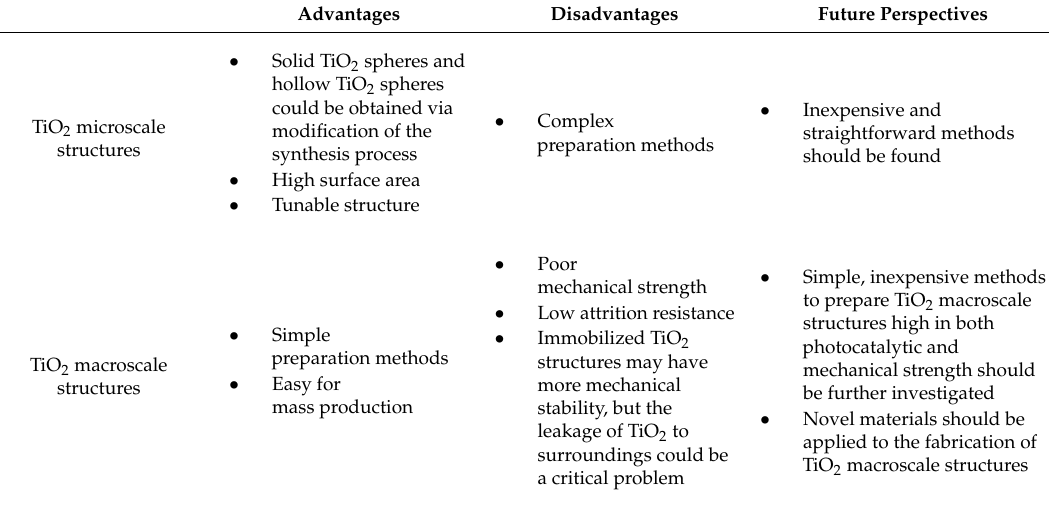
Table 1. Summary of TiO 2 microscale and macroscale